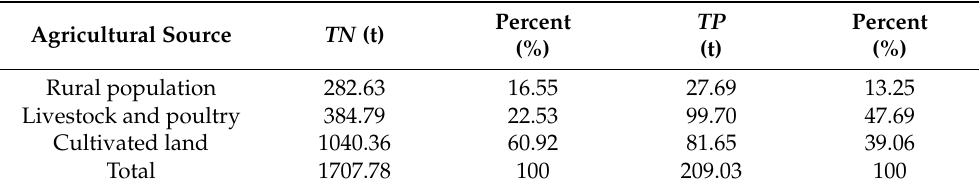
Figure 4. Spatial distribution of major parameters of PTRE – NPS of TP in the Hongfenghu reservoir watershed. Table 3. TN and TP loads from agricultural NPS into the rivers and lakes of the Hongfenghu reservoir